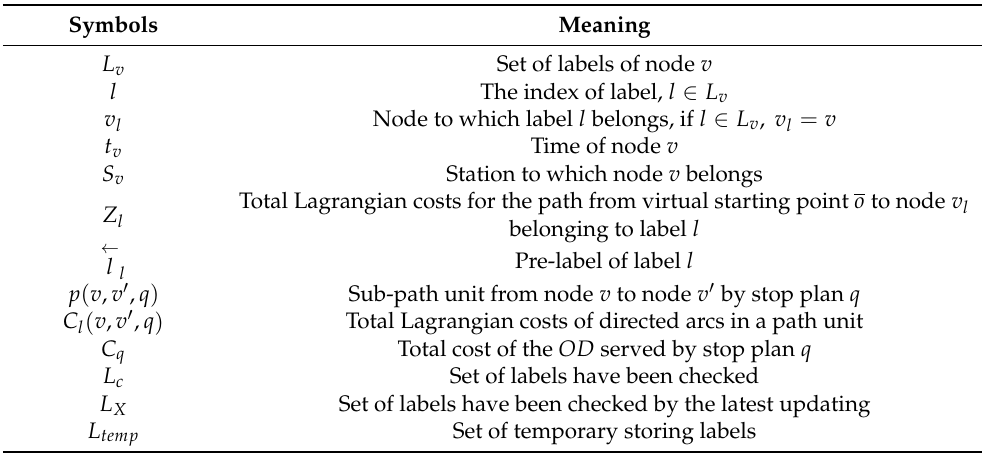
Table 4. Symbols used in the algorithm